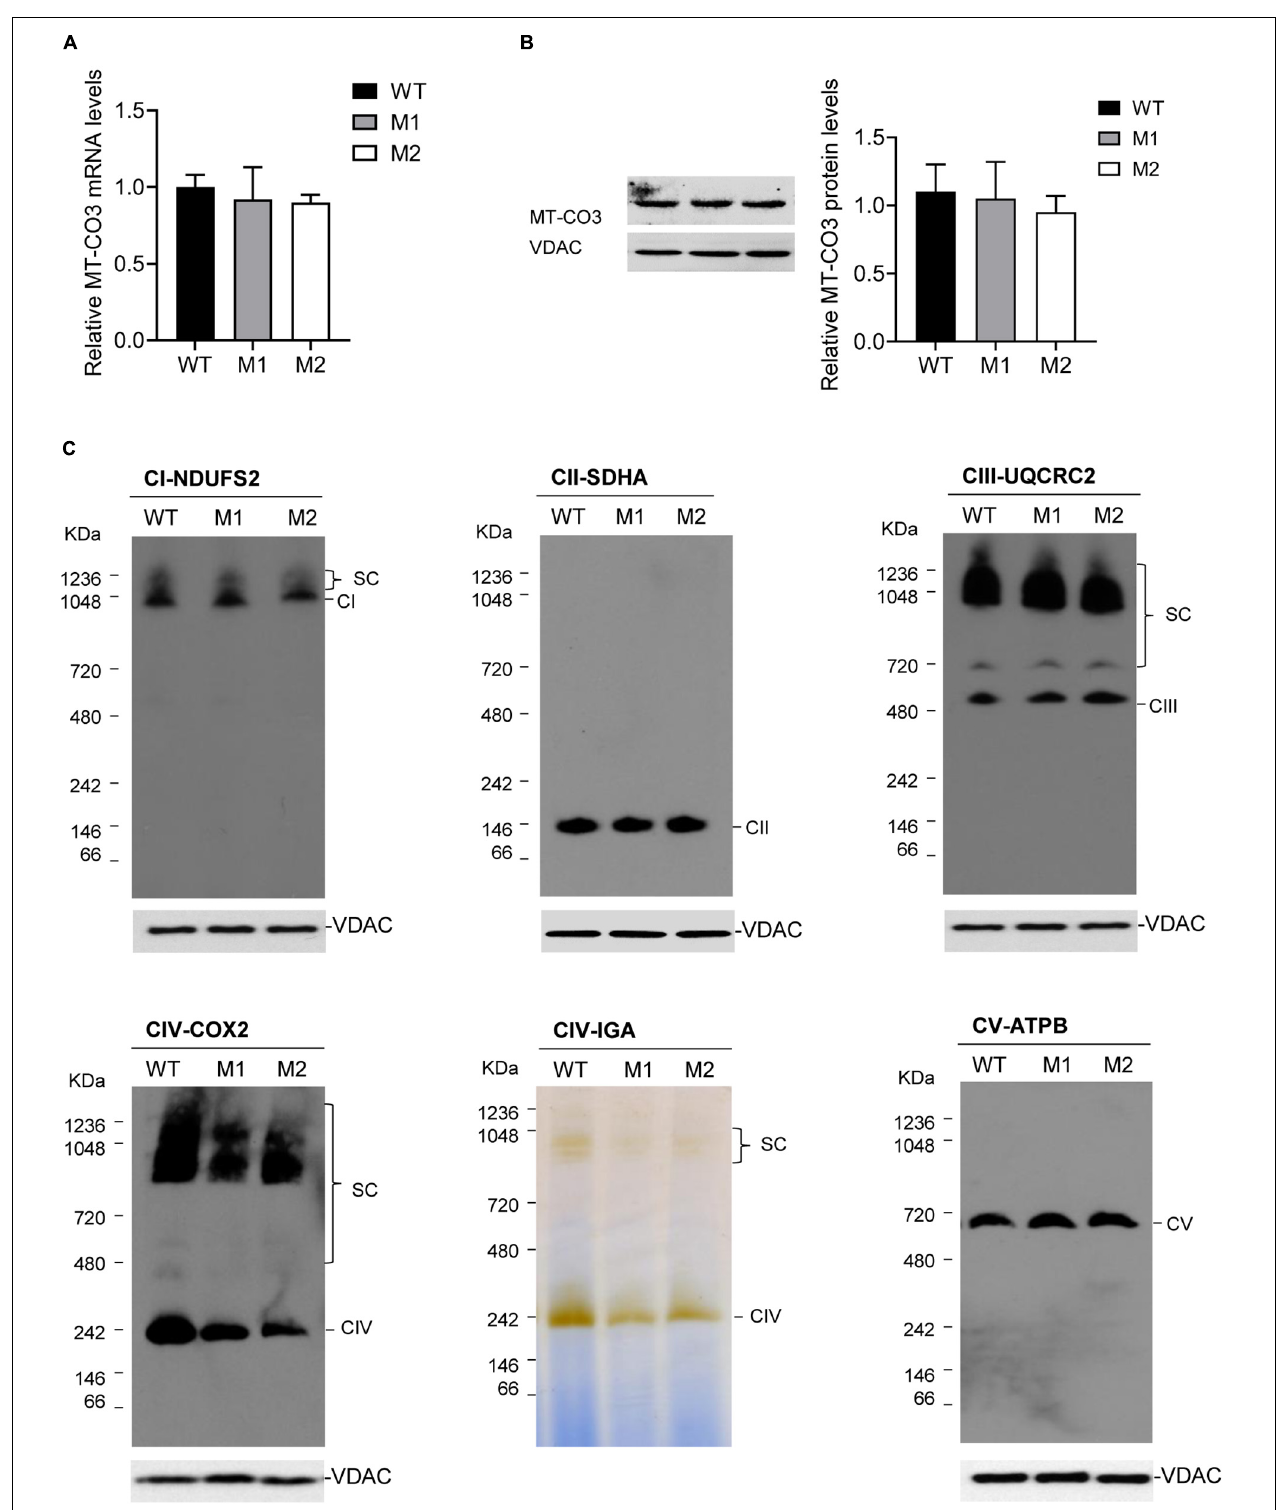
FIGURE 4 | Effect of the m.9396G > A variant on transcript and protein levels. (A) Relative MT-CO3 mRNAs levels in cybrids M1 and M2 relative to that in WT cybrids. (B) Relative MT-CO3 protein levels in cybrids WT, M1, and M2 determined by Western blotting. VDAC was used as the internal control. (C) For cybrids WT, M1, and M2, IGA analysis of CIV and BN-PAGE/immunoblot analysis of MRC complexes using antibodies against subunits of complexes I (NDUFS2), II (SDHB), III (UQCRC2), IV (COXIV), and V (ATPB). VDAC was used as the internal control. CI, complex I; CII, complex II; CIII, complex III; CV, complex V; SC, supercomplex.